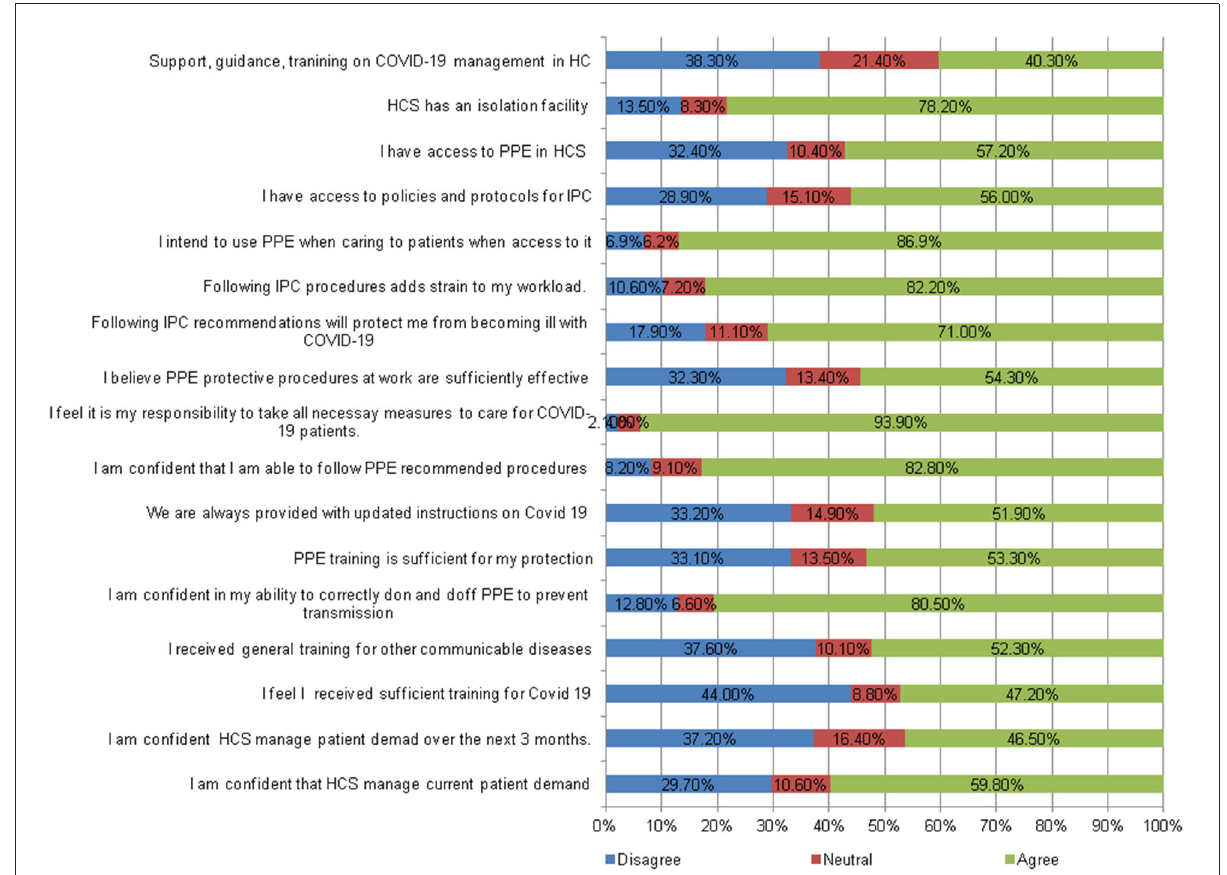
FIGURE1 Perceptions of healthcare workers on recommended IPC use intentions, skills, belief in consequences and capabilities, social role, and environmental